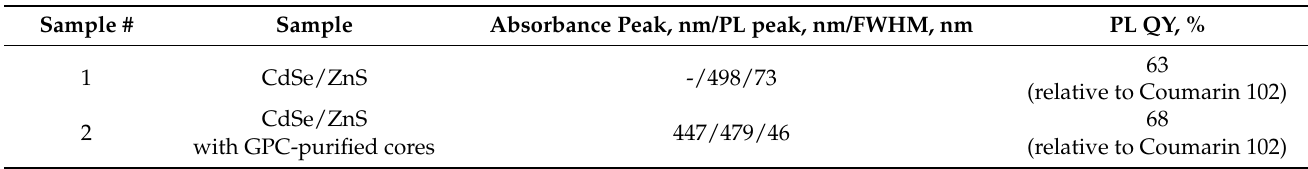
Table 1. Main optical characteristics of CdSe/ZnS QDs with cores purified using different procedures.